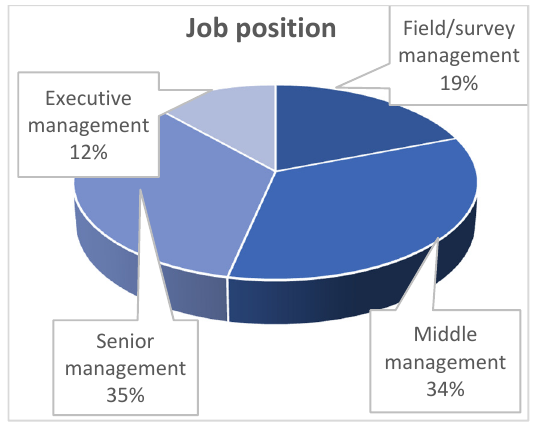
Figure 2. The job position held by respondents (n = 146).